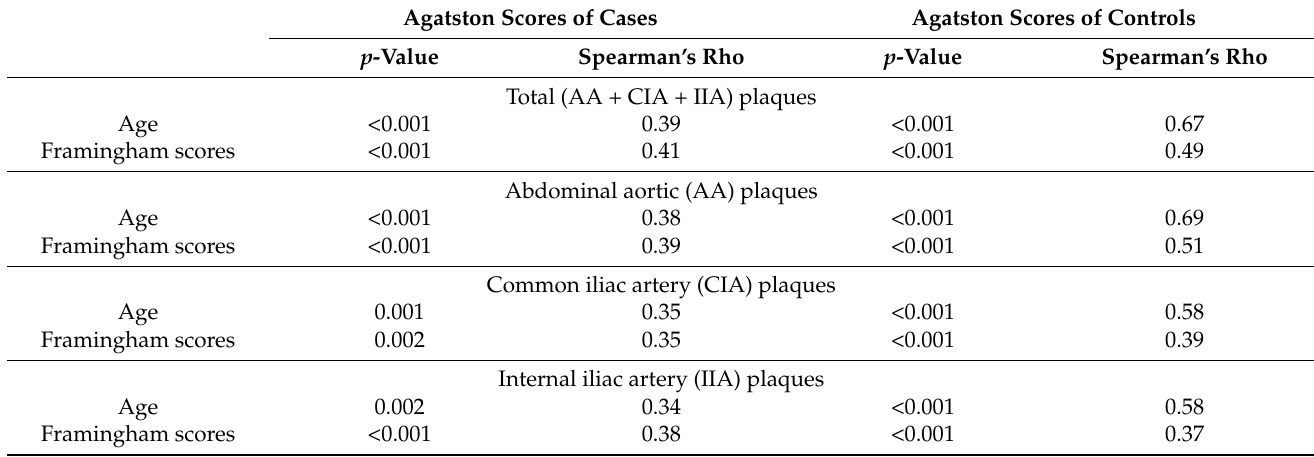
Table 3. Correlation of abdominal aortic and iliac Agatston scores with CVD risk factors for Cases and Controls.